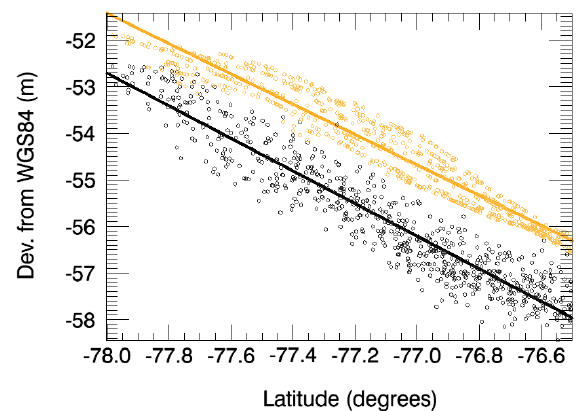
Figure 2. Systematic sampling of every 100 th shot in the record of all h ELEV values (black) and EGM2008 (orange). The dominant trend in the h ELEV is clearly the geoid. The modelled trend is representative of the